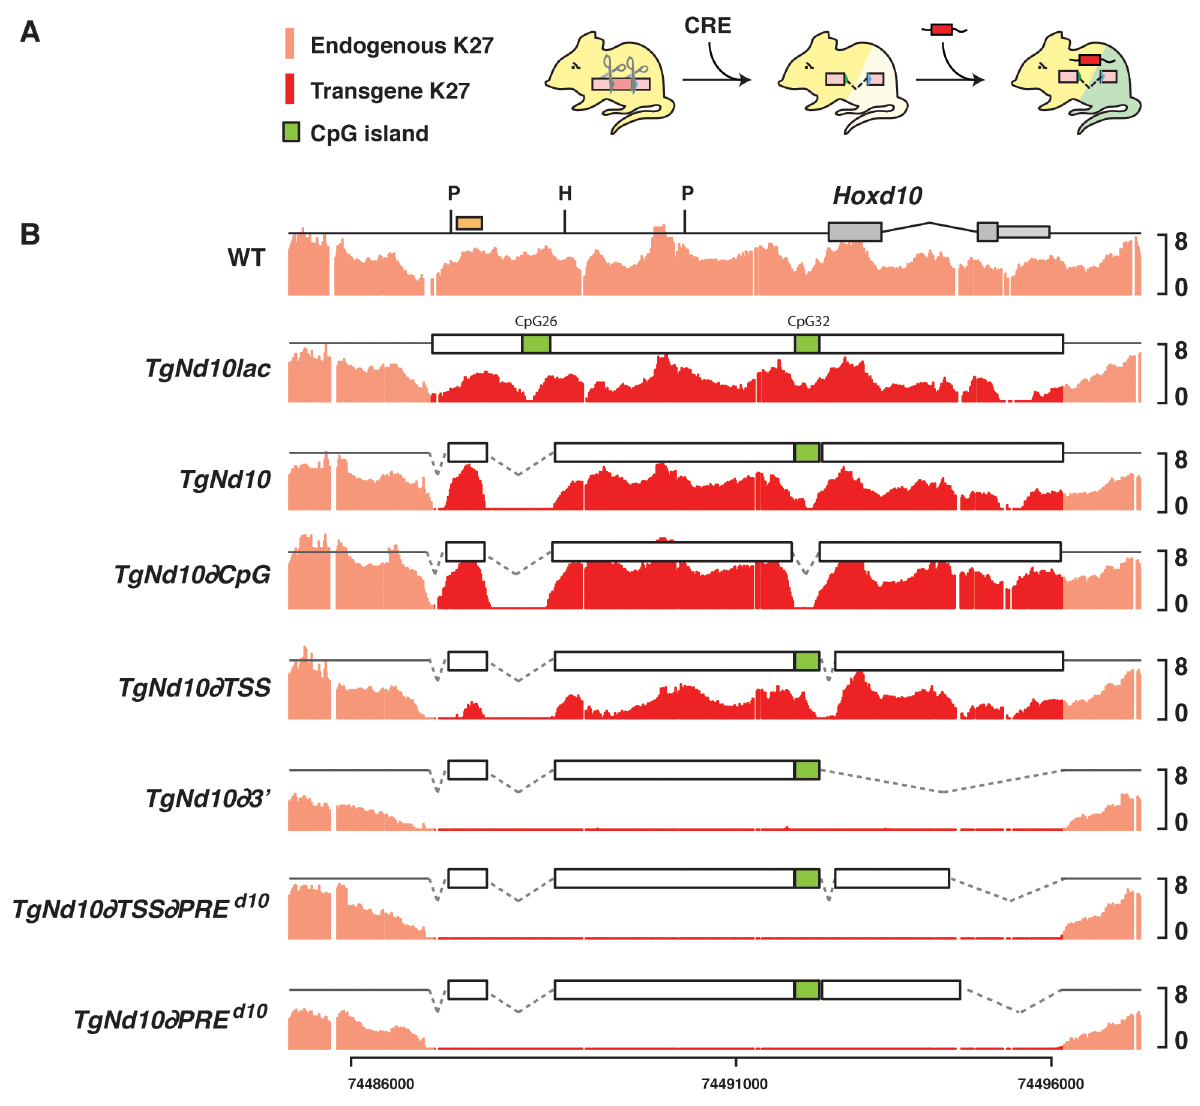
Figure 4. H3K27me3 profiles on transgenes inembryo . (A) Experimental setup, with a portions of the Hoxd10 region injected into mice harboring a deletion of Hoxd10 such as to distinguish between the methylation covering the endogenous locus (light red) and the transgene (dark red). (B) H3K27me3 profiles of wild type and animals carrying a transgene corresponding to the entire part -or portions thereof- of the DNA segment deleted in the del(10) allele. Methylation over the transgenic construct(s) is depicted in dark red. CpG islands are shown as green boxes. The orange box in the WT profile indicates the position of the probe for Southern blot in which PvuII (P) and HindIII (H) were used for digestion (see figure S3).